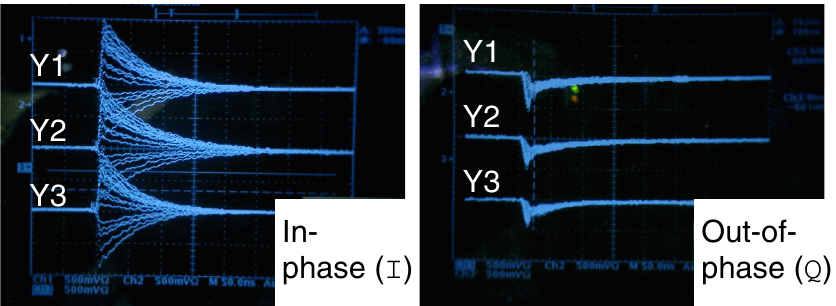
FIG. 11. (Color) Example of the output signals. After finishing the phase tuning procedure with a 30 dB attenuation setting, this example data was taken with 10 dB attenuation in the natural beam jitter. The scope was set to persistence mode, superposition of many pulses were shown in the picture. These pulses are recorded by charge